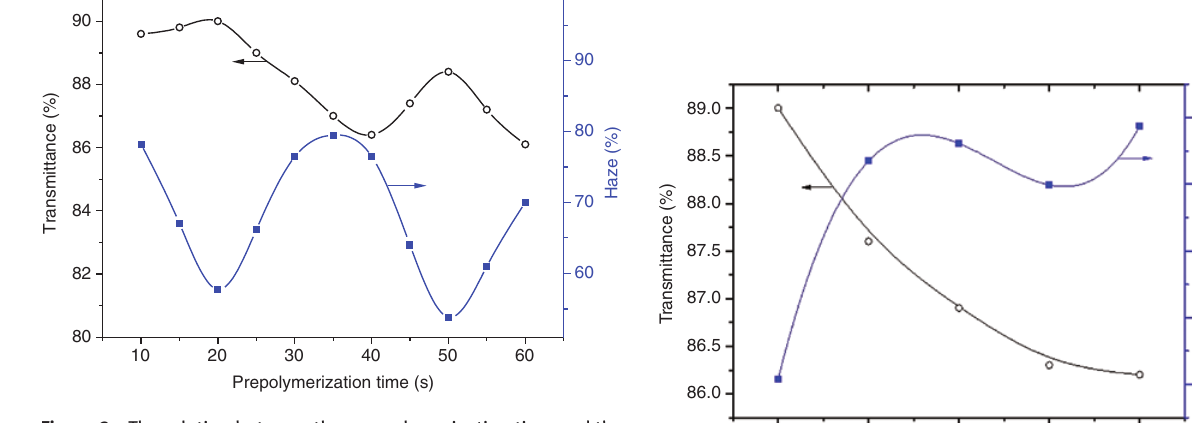
Figure 2: The relation between the pre-polymerization time and the optical performance of the sample (the concentration of prepolymer is 0.2%, the pre-polymerization temperature is 80 ° C, the concentra- tion of BPO is 0.5%, the sample is measured after 47 days in room temperature).